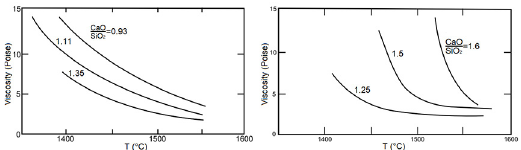
ratio on viscosity in a) 2